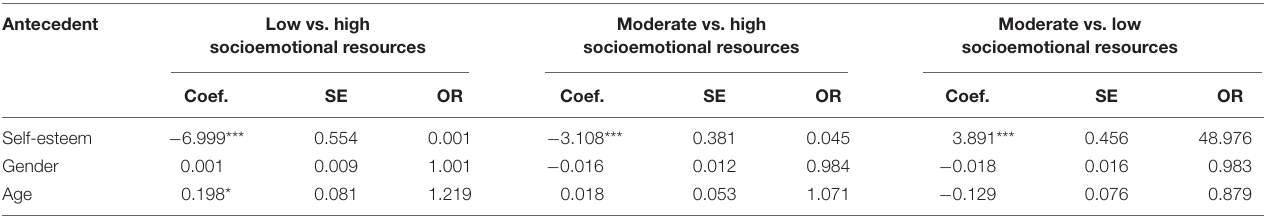
TABLE 4 | Three-step results for antecedents